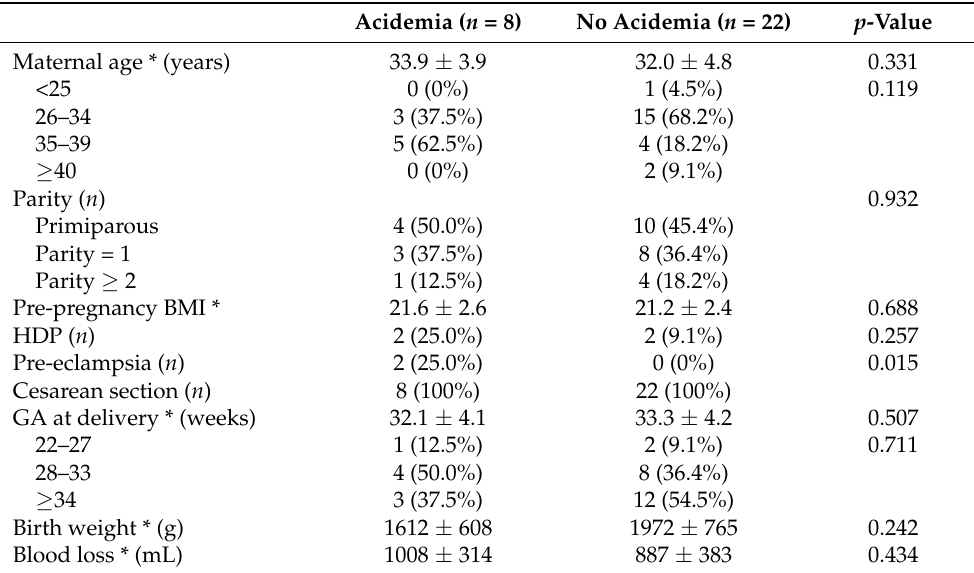
Table 5. Demographics and obstetrical characteristics of the validation set.